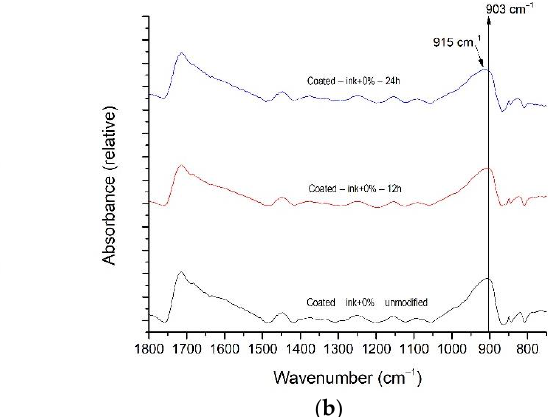
( b ) Figure 7. FTIR-ATR spectra of unmodified and modified ink films with addition of nanoparticles: ( a ) TiO 2 (A) on coated paperboard and ( b ) ZnO on uncoated paperboard.